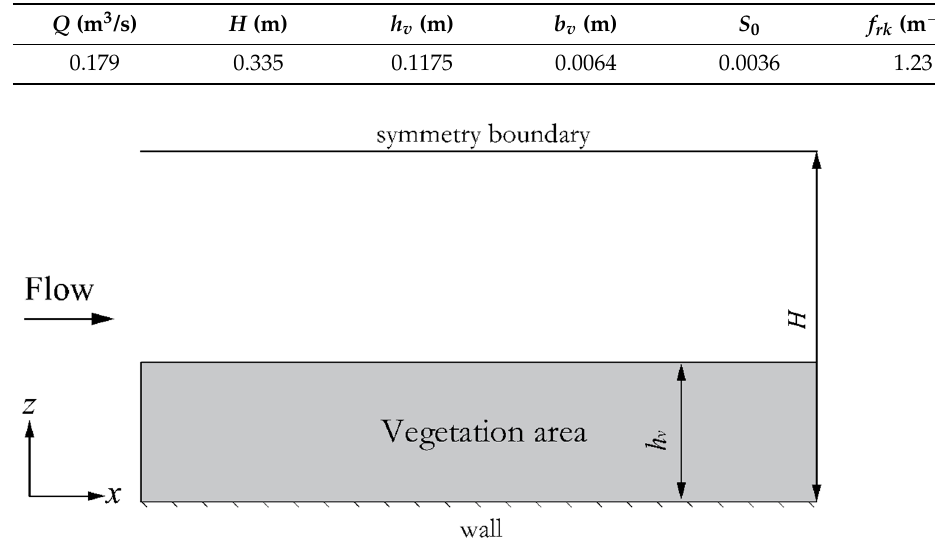
Table 1. Physical model parameters in Dunn et al. (1996).